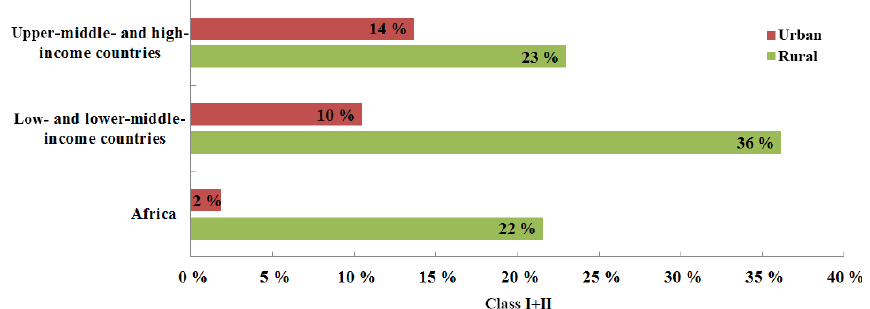
Figure 3. Average percentage of urban and rural buildings belonging to vulnerability classes I and II for different income groups and Africa according to PAGER for countries with different urban–rural